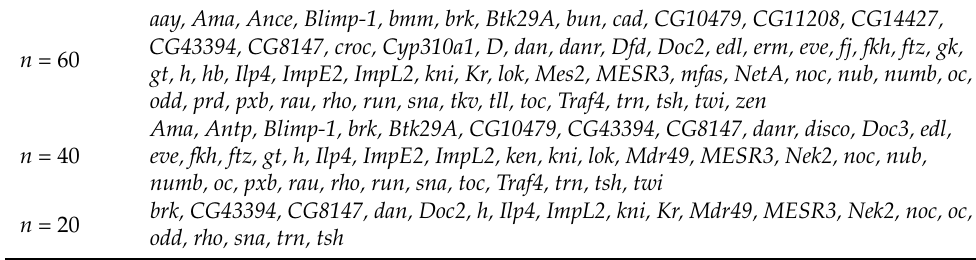
Table 1. Final subset of genes identified for each n .